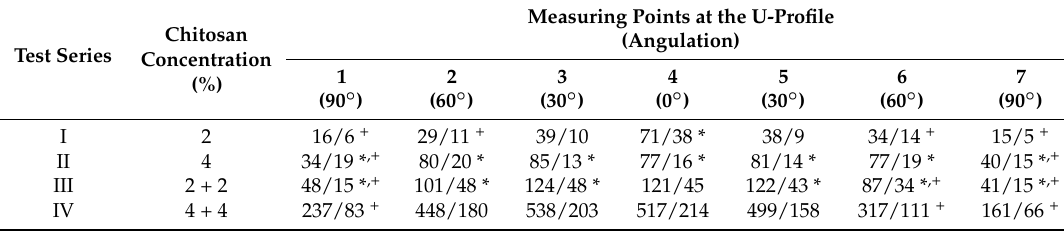
Table 1. Measured chitosan thickness ( µ m; mean/SD). Asterisks (*) indicate similar measuring points between the four test series that were not statistically significantly different. Superscript crosses ( + ) indicate measuring points within each test series were statistically significantly different from the center of the U-profile (measuring point 4).